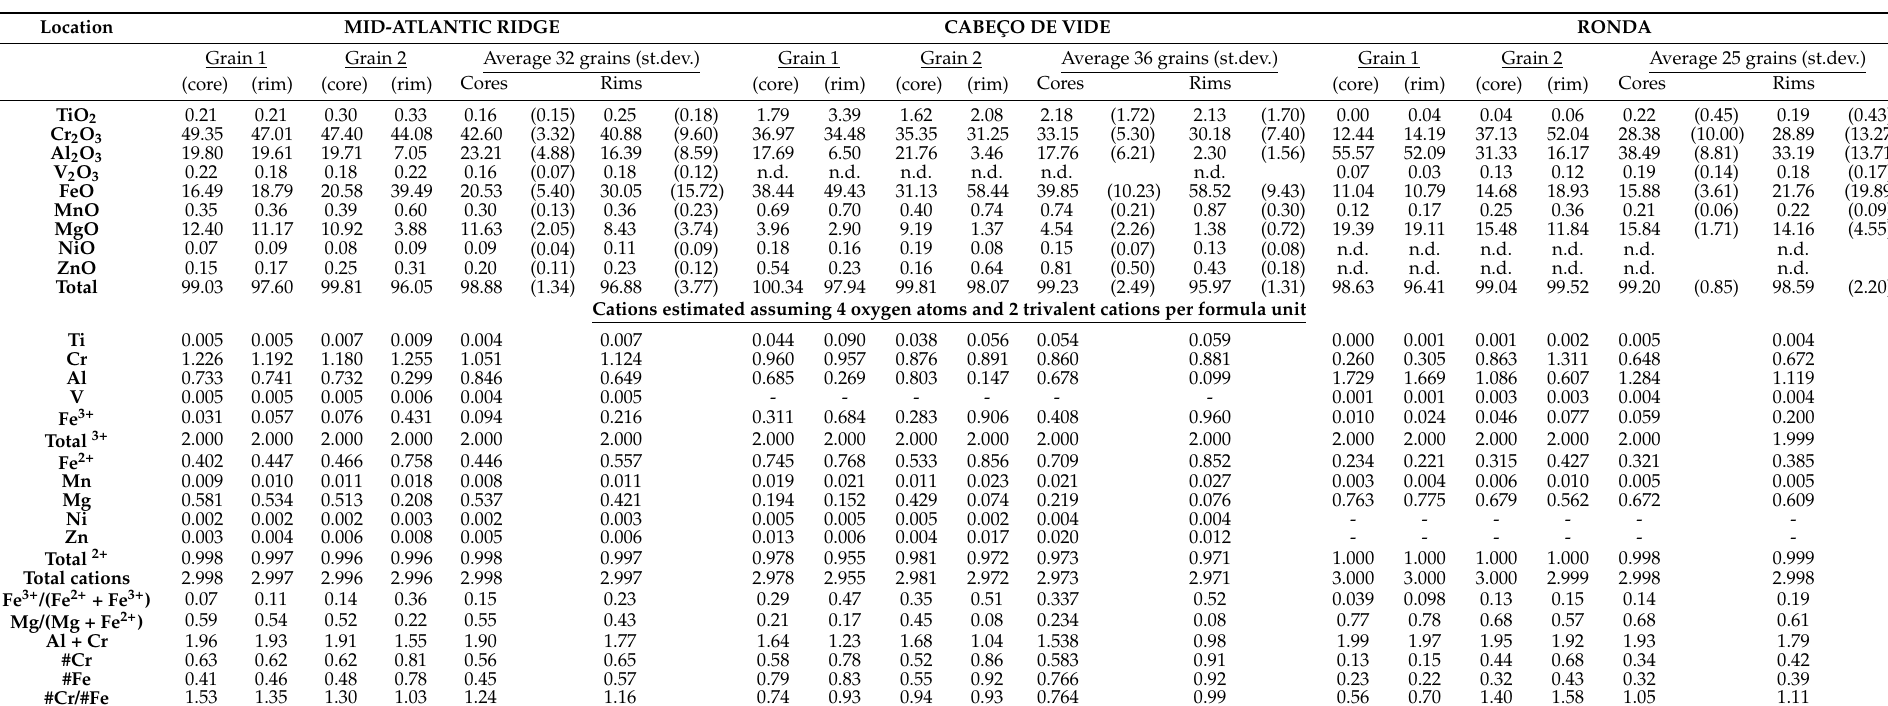
Table A1. Representative and average EMP data and structural formulae of chromites from the MAR (Rainbow and Saldanha sites), Cabeço de Vide (Alter do Ch ã o Massif, Portugal) and Ronda (SW Spain) serpentinites. The selected representative analyses show minimum and maximum oxidation effects. Cations per formula unit were estimated on a basis of four oxygen atoms and assuming full occupancy of the B (trivalent cation)